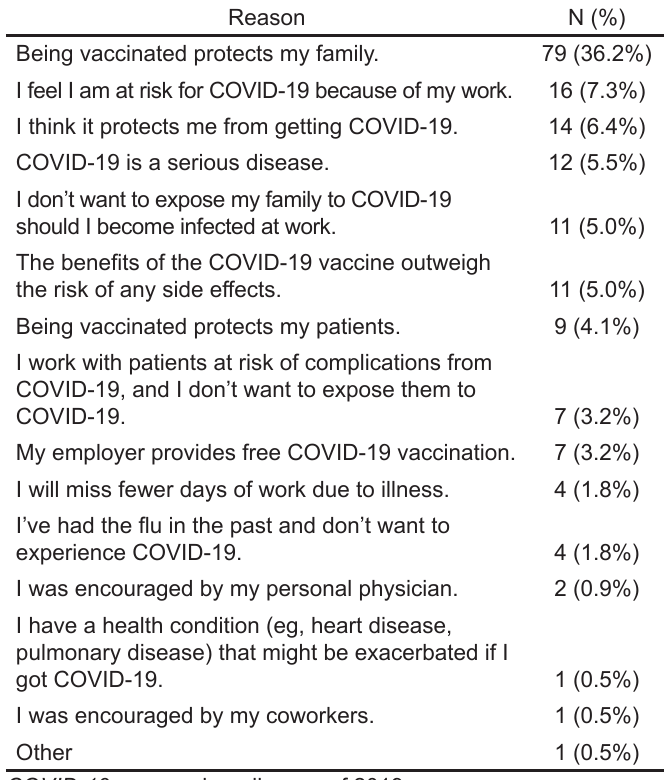
Table 4. Reasons why respondents accepted COVID-19